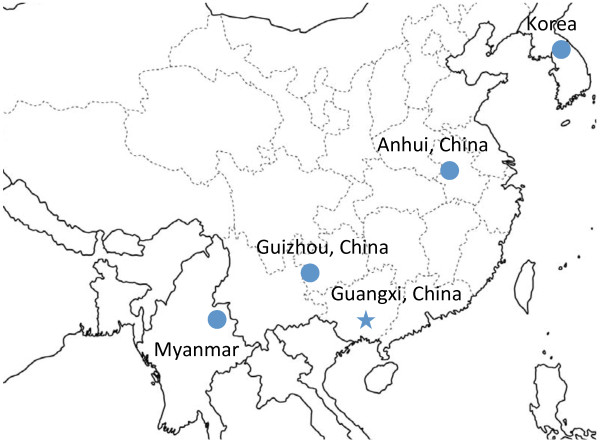
Distribution of P. vivax sampling sites. Circles indicate sampling sites in the present study, while the star marks the location of Guangxi province (a possible earlier sampling site).